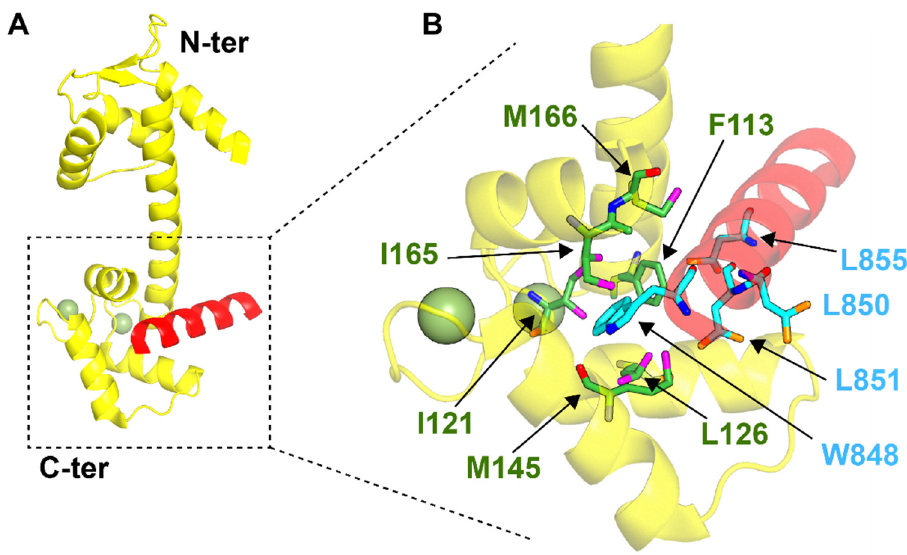
Figure 2. Crystal structure of the complex HsCEN2/P17-XPC (PDB: 2OBH). ( A ) Global view of the complex. The centrin molecule is represented in yellow and the P17-XPC peptide is shown in red. The Ca 2+ ions at the C-terminal binding sites of the centrin molecule are represented as smudge green spheres. ( B ) Magnification of the binding site of HsCEN2. Key residues, defining the interface of interaction, are reported as green (HsCEN2) and cyan (P17-XPC)